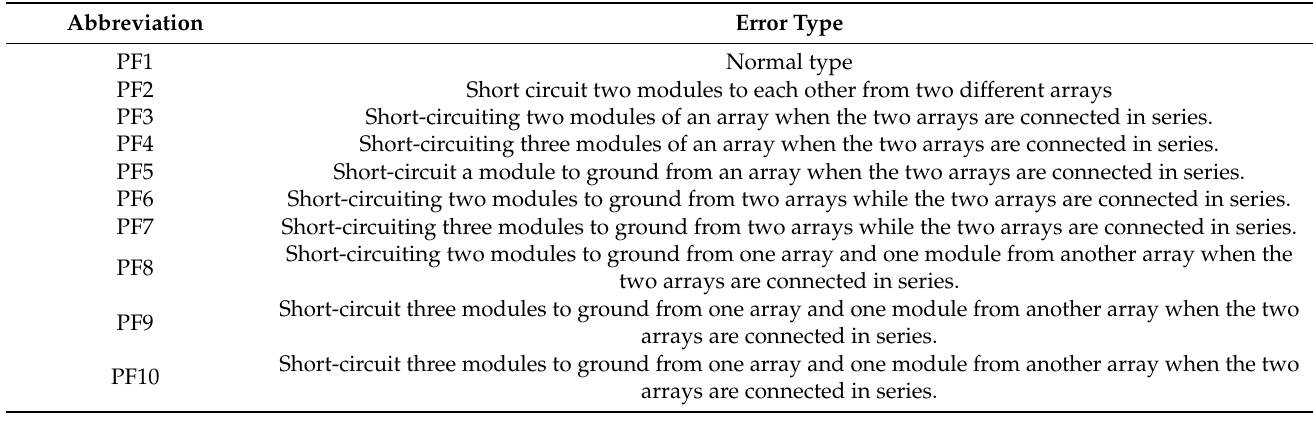
Table 1. List of errors checked (NT-R5E3E PV module) [24].